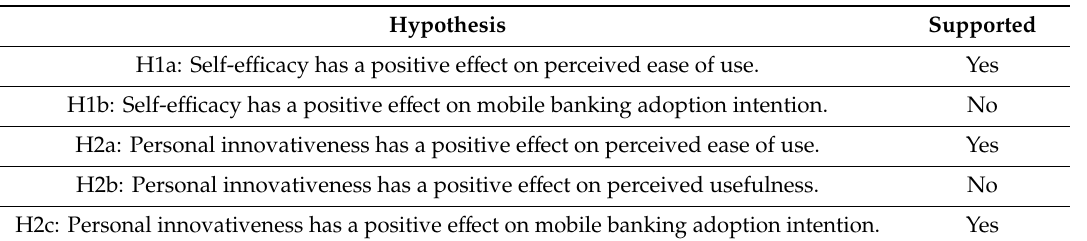
Table 8. Results of Hypotheses